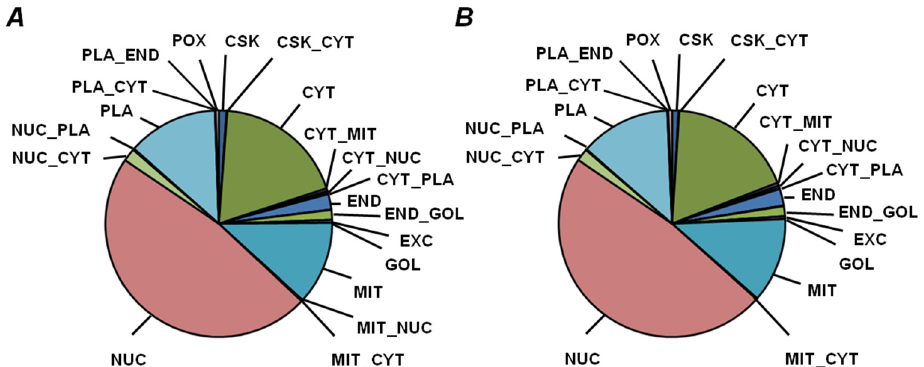
Figure 6. Prediction of subcellular localization of proteins, identified ( A ) in yellow seeds of cultivar Millennium and ( B ) in green seeds of cultivar Gloriosa, both in nondepleted samples and after treatment with 0.07% ( w/v ) protamine sulfate. Subcellular fractions: CSK, cytoskeleton; CYT, cytoplasm; END, endoplasmic reticulum; EXC, extracellular/secreted; GOL, Golgi apparatus; MIT, mitochondria; NUC, nuclear; PLA, plasma membrane; POX, peroxisome; doubled labels denote corresponding combinations of possible localization.